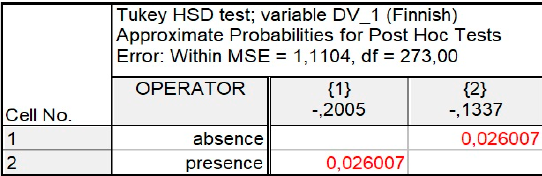
Figure 9. Operator mean results (Finnish) .